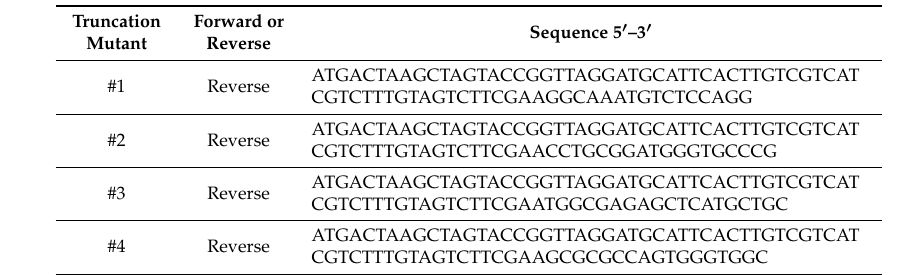
Table 2. Primer sequences for truncation